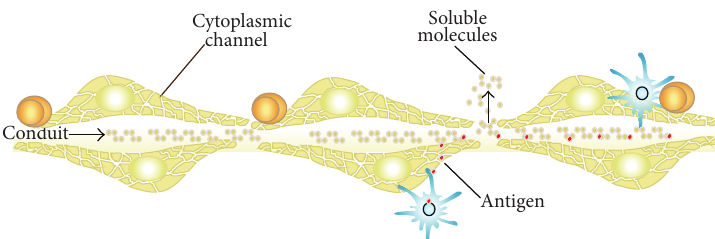
Figure 1: Schematic representation of FRCs. They are spatially arranged so as to delimit a conduit channel that drives soluble molecules. Other structures evidenced are the FRC intracellular cytoplasmic channels, through which antigens are transported from the lymph to the nearby-lying antigen-presenting